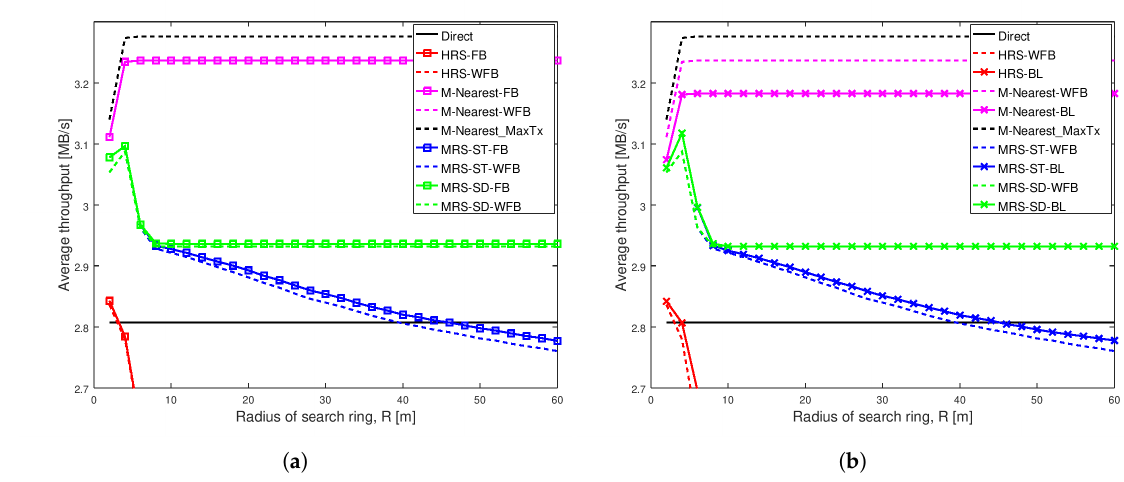
Figure 6. Average throughput of different schemes when Shape = 2 and Scale = 0.5 in a network having width of 100 m. ( a ) Different battery power levels not considered in relay selection; ( b ) Different battery power levels considered in relay